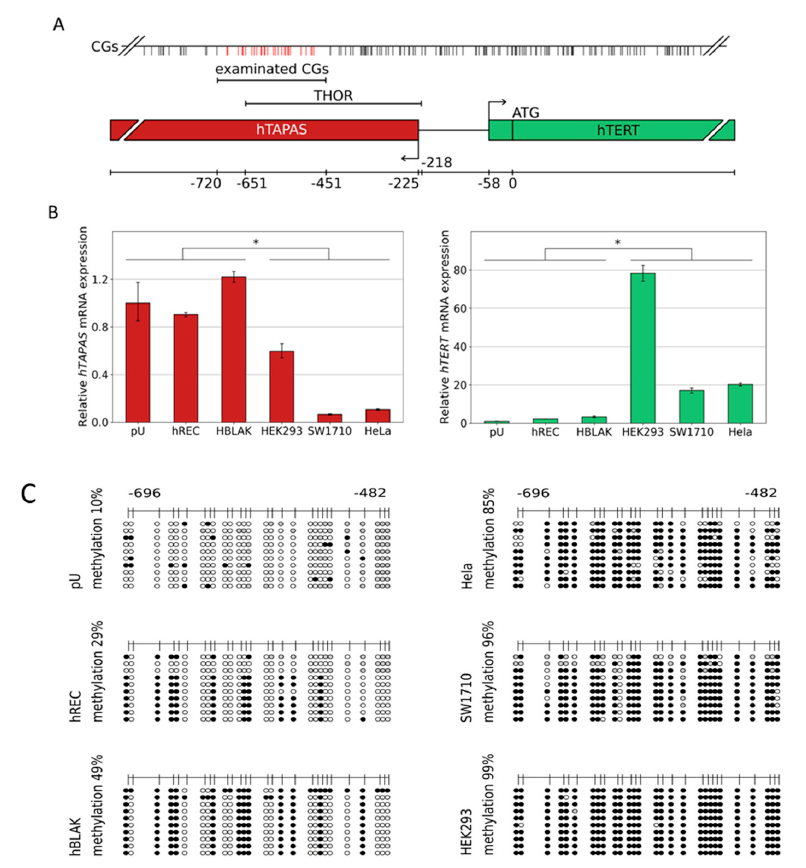
Figure 1. Relative hTAPAS and hTERT expression and THOR DNA methylation patterns in various cell types. The above-depicted illustration ( A ) provides the exact location of the examined CpG rich region and further details, e.g., the proportional distribution of the CpG dinucleotides within this genomic area. Primary urothelium and the cell lines hREC, HBLAK, HEK293, SW1710, and HELA were used to measure the expression of lncRNA hTAPAS and HTERT gene. * p ≤ 0.05 ( B ). In addition, the detailed DNA methylation patterns of a 215 bp 5 ′ - fragment within THOR, ranging from − 482 to − 696 relative to the translational start site of HTERT gene, was determined from those cell types. ( C ). Here, every unmethylated CpG dinucleotide is represented by a blank circle, every methylated one by a black circle, and non-defined CpG positions are depicted by grey circles.